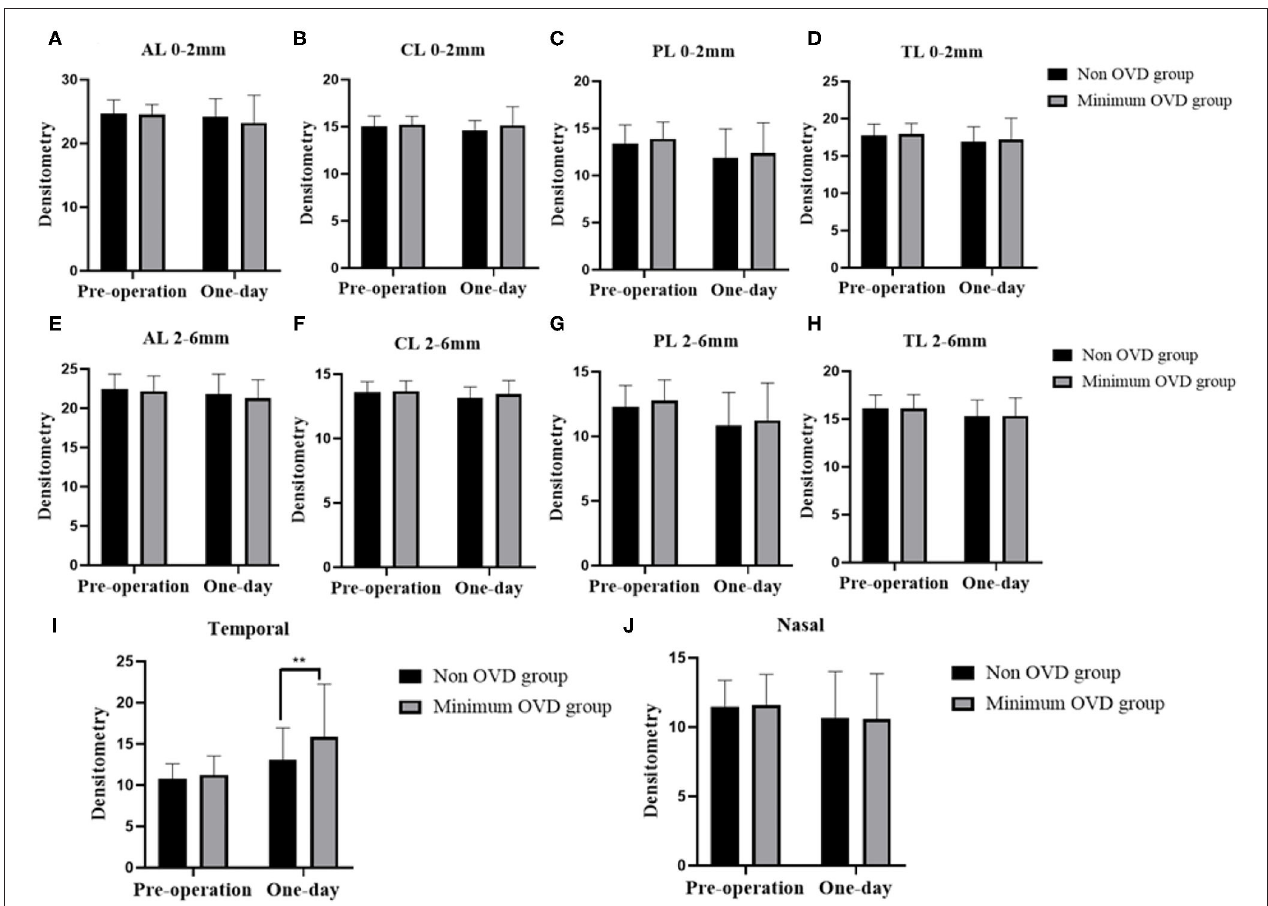
FIGURE 3 | Densitometry of the cornea in the non-OVD group and min-OVD group at different time points postoperatively. Corneal densitometry values of the anterior layer (A) , central layer (B) , posterior layer (C) and total layer (D) from 0 to 2mm. Corneal densitometry values of the anterior layer (E) , central layer (F) , posterior layer (G) and total layer (H) from 2 to 6mm. Corneal densitometry values of temporal (I) and nosal (J) part. ** P < 0.01, the error bar indicates the standard